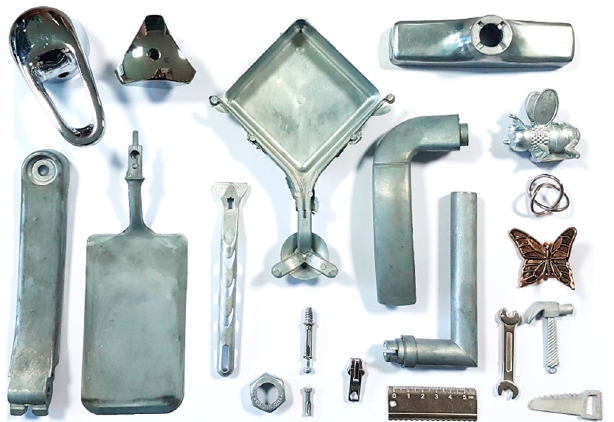
Figure 1. Examples of cast zinc-base alloys products.